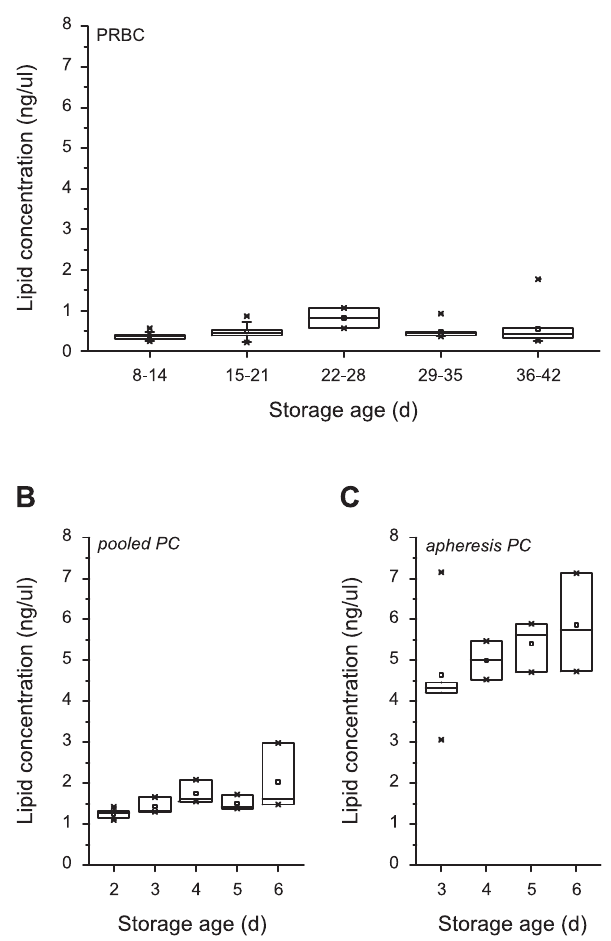
Figure 4. Storage-dependency of lipid concentration in blood products. Storage-dependent concentration of lipids in packed red blood cells (PRBC) (A), and in pooled (B) and apheresis platelet concentrates (C). Concentrations of lipids were determined using the sulfo-vanillin colorimetric method. Results are shown as medians with interquartile ranges.